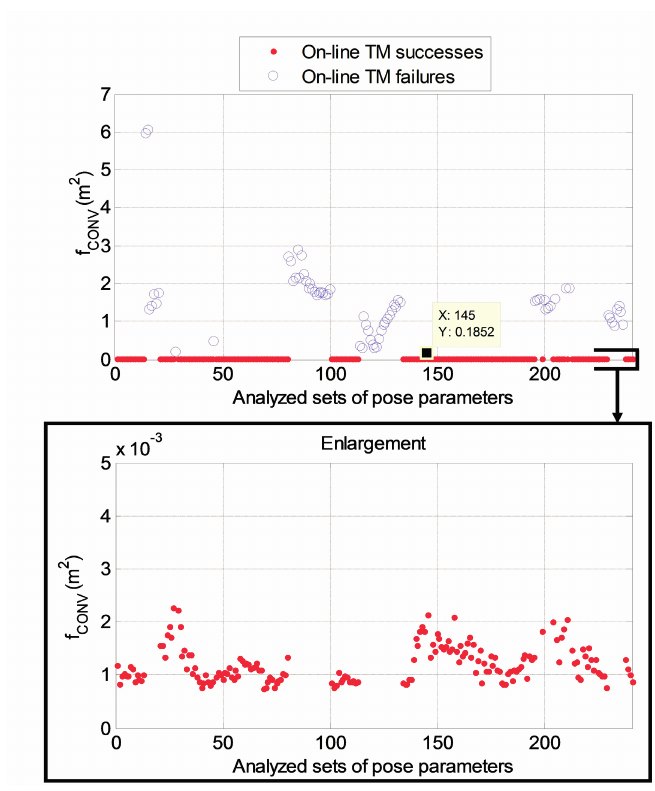
Figure 9. ( Up ) Value of the ICP cost function at convergence for the considered two-orbit sequence of poses; ( Down ) Enlargement of the same graph. The red dots correspond to successes for the TM algorithm, while the blue circles indicate the failures. The maximum value of f CONV which corresponds to algorithm failure is highlighted.